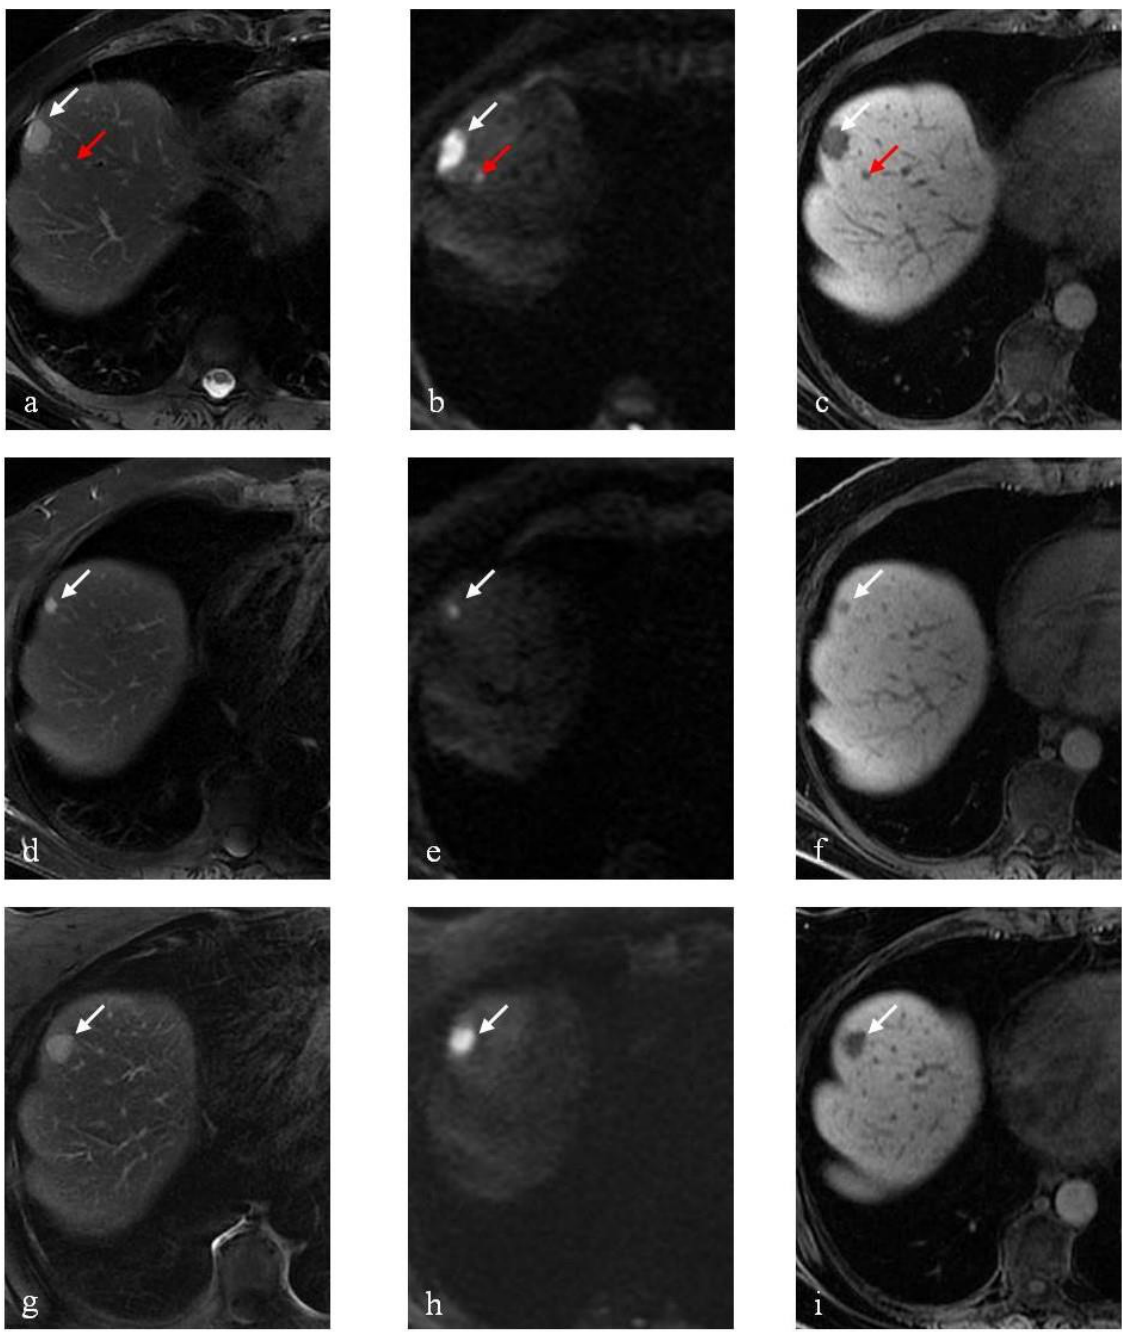
Figure 5. A 45-year-old female who had a DLM and SRLM after chemotherapy. Two liver metastases in segment VIII sized 18 mm and 4 mm (white and red arrows) were observed on T2-weighted ( a ), diffusion-weighted ( b ) and hepatobiliary phase ( c ) images of baseline MRI. After chemotherapy, the size of the bigger metastasis decreased to 7 mm (white arrow), while the smaller one became invisible on T2-weighted ( d ), diffusion-weighted ( e ) and hepatobiliary phase ( f ) images of follow-up MRI. The SRLM showed progression on T2-weighted ( g ), diffusion-weighted ( h ) and hepatobiliary phase ( i ) images of a 2-year follow-up MRI; the DLM did not show any